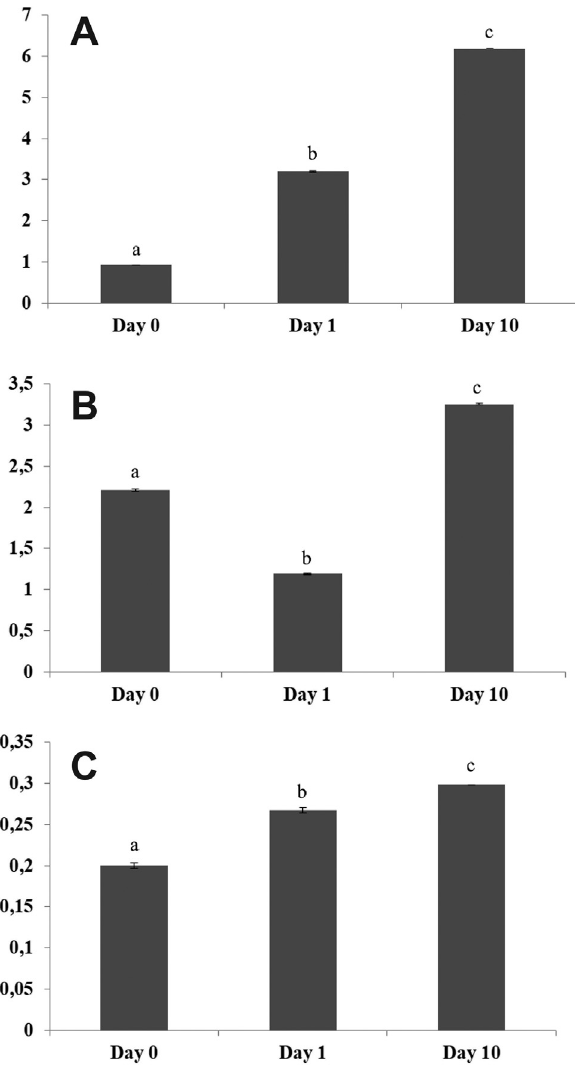
Figure 8 - Densitometric analysis of semi-quantitative RT-PCR (Figure S3) for CaNRTa (A), CaNRTb (B) and CaNRTc (C) using ImageJ 1.43 U software. EF1 (cid:4) gene was used as an internal control to normalize the ex- pression level. The data represent the mean (cid:3) standard deviation of three biological replicates. Letters indicate significant differences between ge- notypes in each treatment by Tukey test (p <